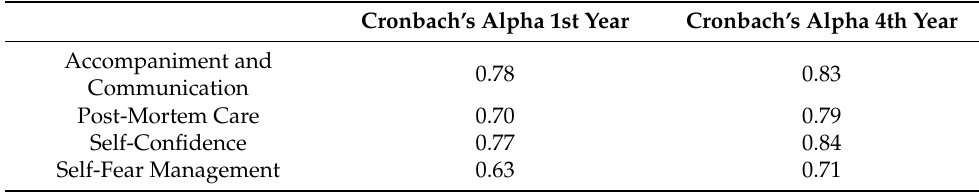
Table 1. Internal consistency analysis of the EBBCAM